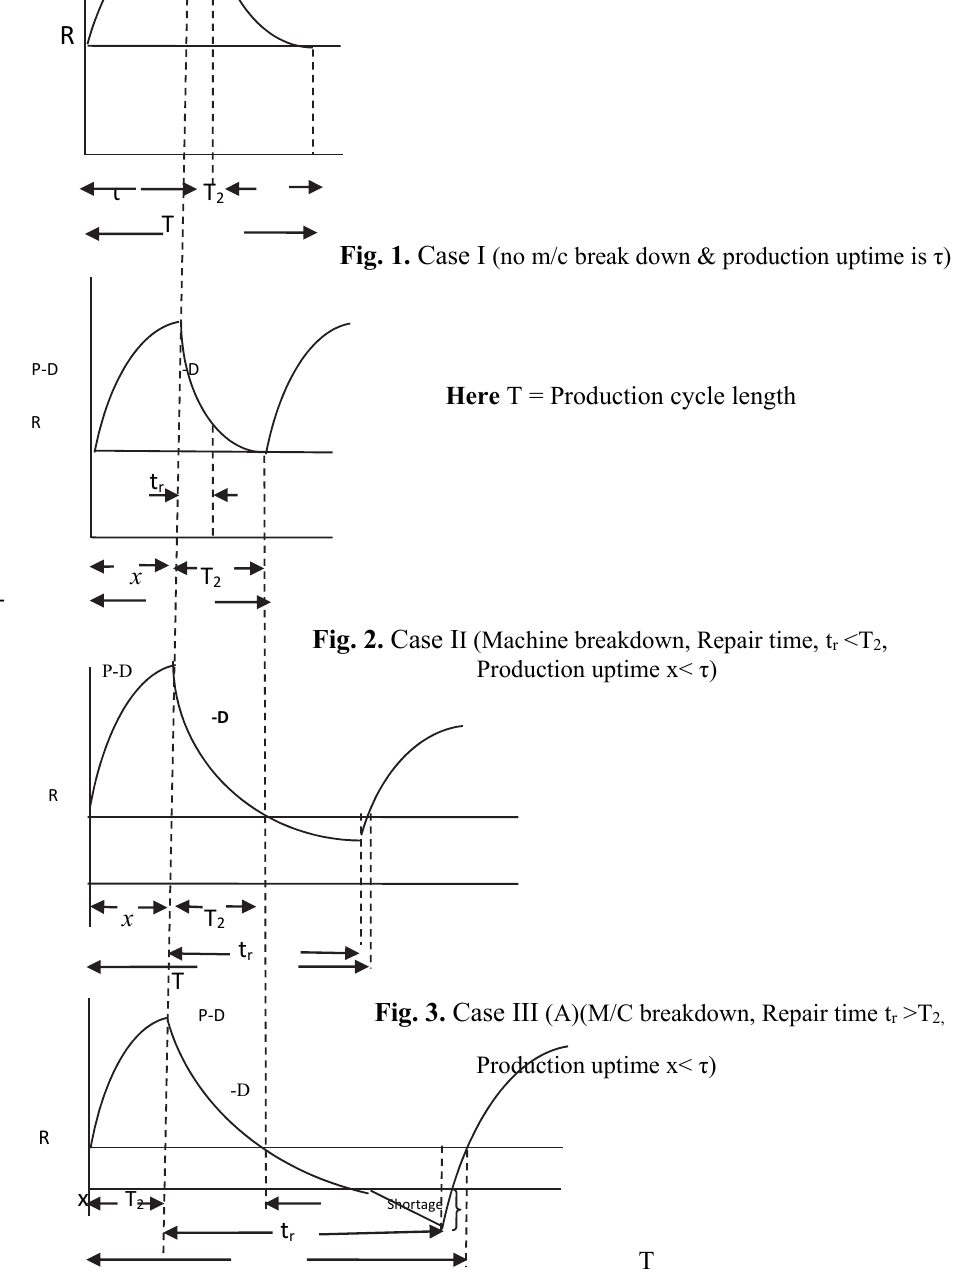
Fig. 1. Case I (no m/c break down & production uptime is τ )